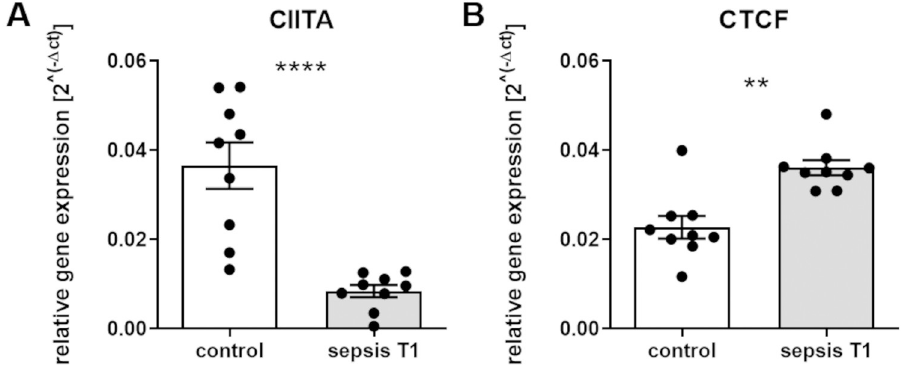
Fig 4. Expression of the transcriptional co-activator CIITA and the superordinate regulator protein CTCF. RNA from isolated human CD14 ++ monocytes was used for reverse transcription and subsequent qPCR using TaqMan Assays against (A) CIITA and (B) CTCF . Relative gene expression was compared between control patients and patients with sepsis at the time of sepsis diagnosis (T1; ���� p < 0.0001 (CIITA) and �� p < 0.01 (CTCF), Mann-Whitney U test, control patients n = 9, patients with sepsis n = 9, mean ±